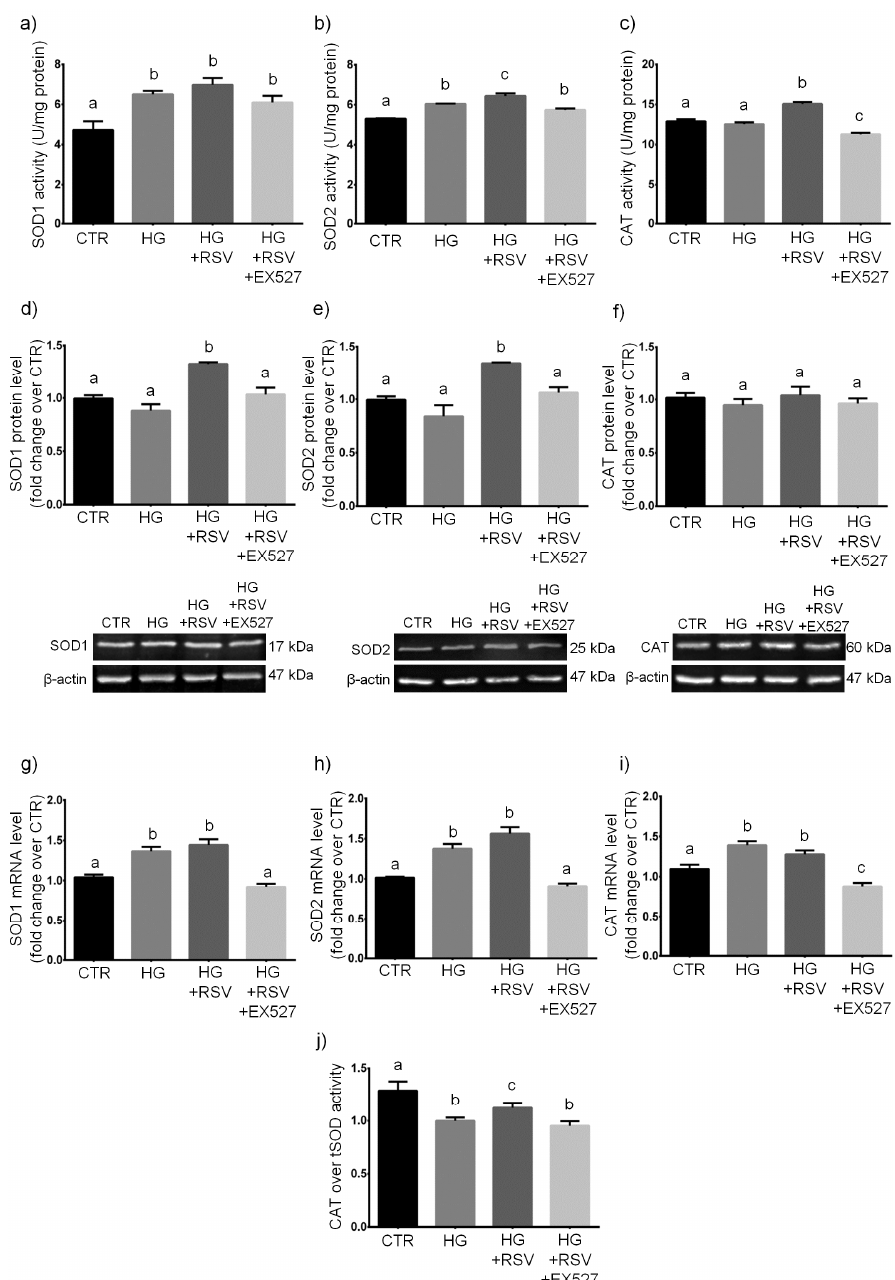
Figure 5. E ff ects of a 24-h treatment with either resveratrol alone (5 µ M) or resveratrol + EX527 (5 µ M and 13.4 µ M, respectively) combination on the enzymatic activity ( a – c ), protein levels ( d – f ), and mRNA content ( g – i ) of superoxide dismutase 1 ( a , d , g ), superoxide dismutase 2 ( b , e , h ), and catalase ( c , f , i ) in high glucose-challenged HUVECs. The catalase over total superoxide dismutase ratio was also shown ( j ), as well as representative blots ( d – f ). Data are expressed as means and S.E.M. Abbreviations: CTR—vehicle; HG—high glucose; HG + RSV—high glucose + resveratrol; HG + RSV + EX527—high glucose + resveratrol + EX527; SOD1—superoxide dismutase 1; SOD2—superoxide dismutase 2; tSOD—total superoxide dismutase; CAT—catalase. Means sharing the same letter are not significantly di ff erent from each other (one-way ANOVA and Tukey’s multiple comparisons test): Panel ( a ): a vs. b, p < 0.05 ( N = 3–4). Panel ( b ): a vs. b, p < 0.05; b vs. c, p < 0.05; a vs. c, p < 0.001 ( N = 3–4). Panel ( c ): a vs. b, p < 0.001; b vs. c, p < 0.001; a vs. c, p < 0.05 ( N = 3–4). Panel ( d ): a vs. b, p < .01 ( N = 4). Panel ( e ): a vs. b, p < 0.05 ( N = 4). Panel ( f ): ( N = 4). Panel ( g ): a vs. b, p < 0.01 ( N = 5). Panel ( h ): a vs. b, p < 0.05 ( N = 3–5). Panel ( i ): a vs. b, p < 0.05; a vs. c, p < 0.05; b vs. c, p < 0.001 ( N = 5). Panel ( j ): a vs. b, p < 0.001; b vs. c, p < 0.05; a vs. c, p < 0.05 ( N =